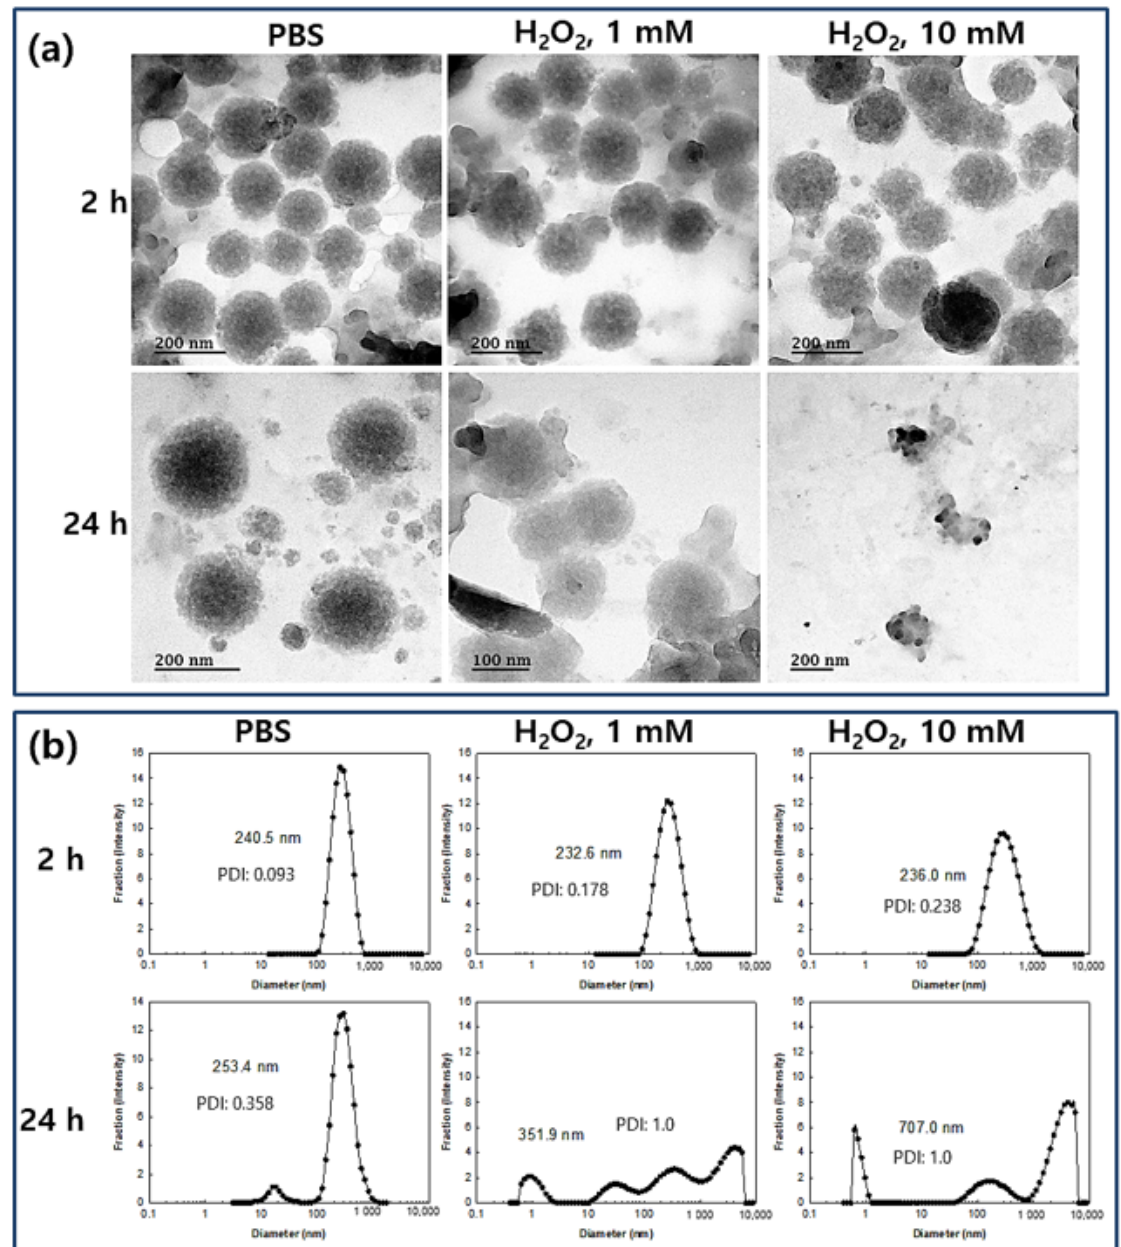
Figure 3. ( a ) TEM images and ( b ) typical particle size distribution of CIP-incorporated LGseseTAPEG nanoparticles. H 2 O 2 was added to the nanoparticle aqueous solution (1 mg/mL (as a polymer weight) in 10 mL PBS) and then incubated them at 37 °C. For TEM observation and particle size analysis, CIP-incorporated nanoparticles (drug content: 10.1% ( w / w )) were used. PDI: polydispersity index.